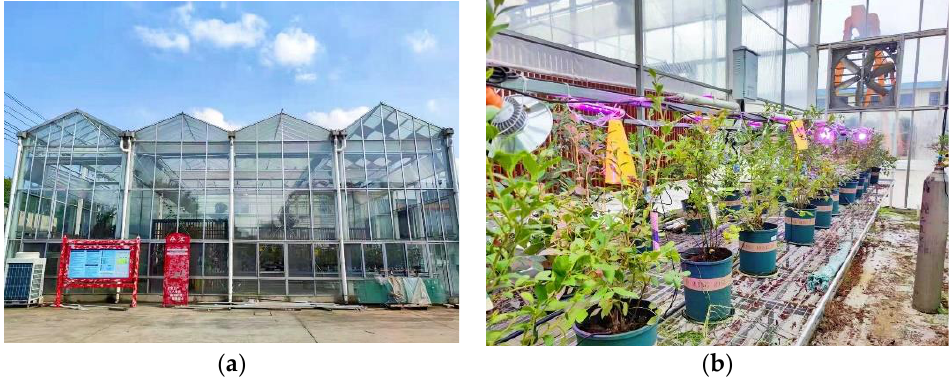
Figure 1. The exterior ( a ) and interior ( b ) of the experimental greenhouse.